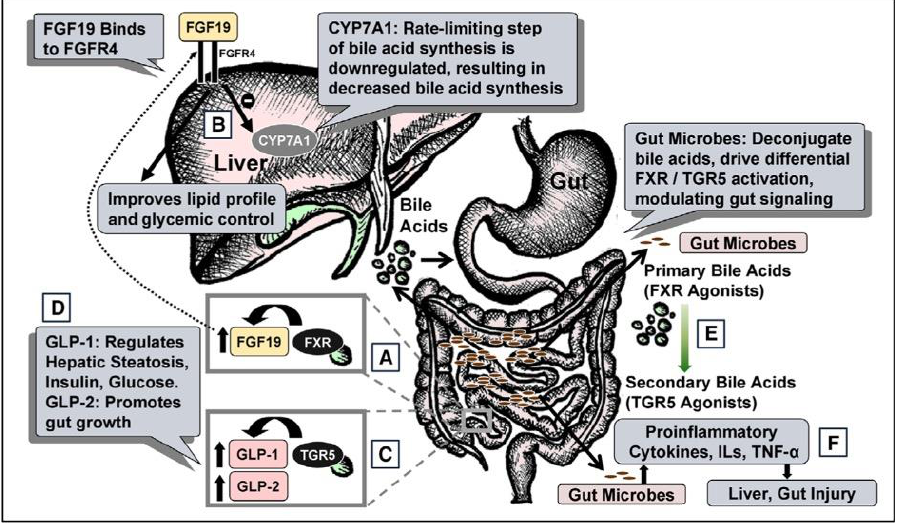
Figure 1. Total Parenteral nutrition Associated injury. ( A ) During regular enteral nutrition, luminal bile acids activate gut farnesoid X receptor (FXR), releasing fibroblast growth factor 19 (FGF19). ( B ) FGF19 regulates hepatic cholesterol 7 α -hydroxylase (CYP7A1), fat, and glucose metabolism. ( C ) Gut TGR5 activation by bile acids releases glucagon-like peptide-1 (GLP-1) and GLP-2. ( D ) GLP-1 modulates hepatic steatosis, insulin, and glucose; GLP-2 modulates gut growth. ( E ) Gut microbes deconjugate primary bile acids (FXR agonists) to secondary bile acids (TGR5 agonists). ( F ) Gut microbes also regulate cytokines, interleukins (ILs), and tumor necrosis factor- α (TNF- α ), modulating liver and gut injury. FGFR4, FGF receptor 4. “Reproduced with permission from American Society for Parenteral and Enteral Nutrition, Nutrition in clinical practice; published by SAGE Publications, Inc., 2020. ” .